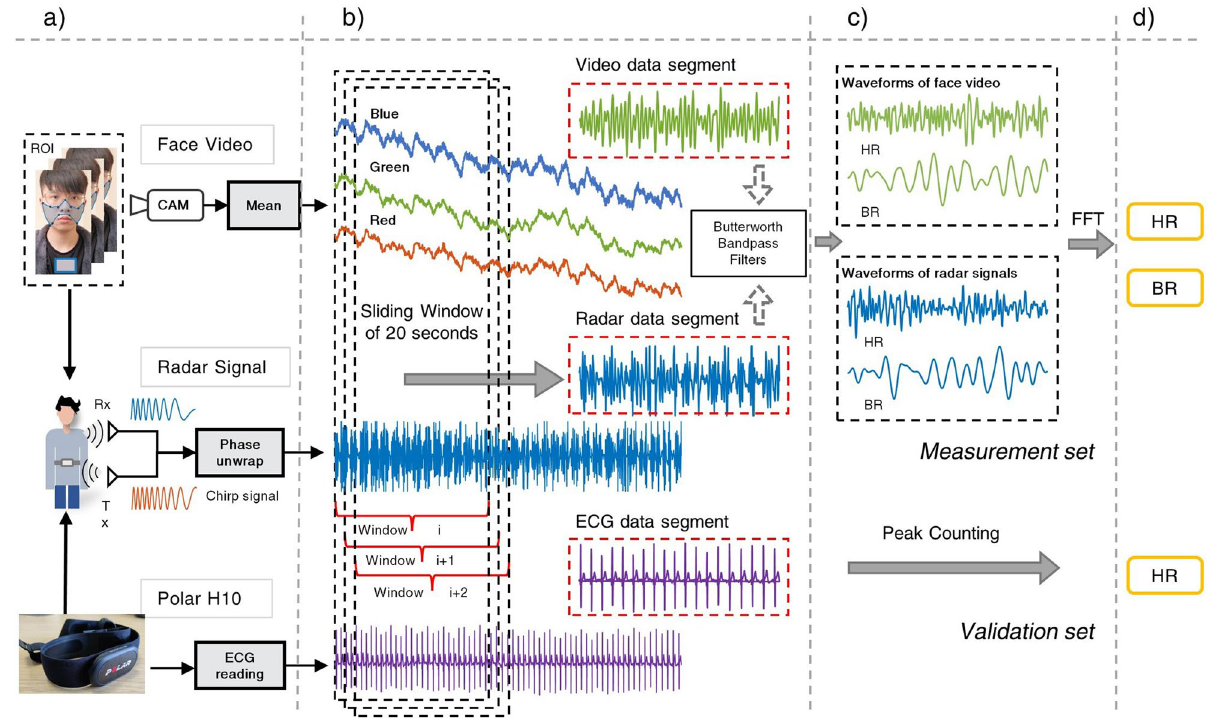
Figure 2. ( a ) The sources for measurement and the initial processing. ( b ) The processed data waveform and the sliding window. ( c ) Filtered waveforms from the remote monitoring systems and the estimation methods. ( d ) The final estimations from the measurement set and validation